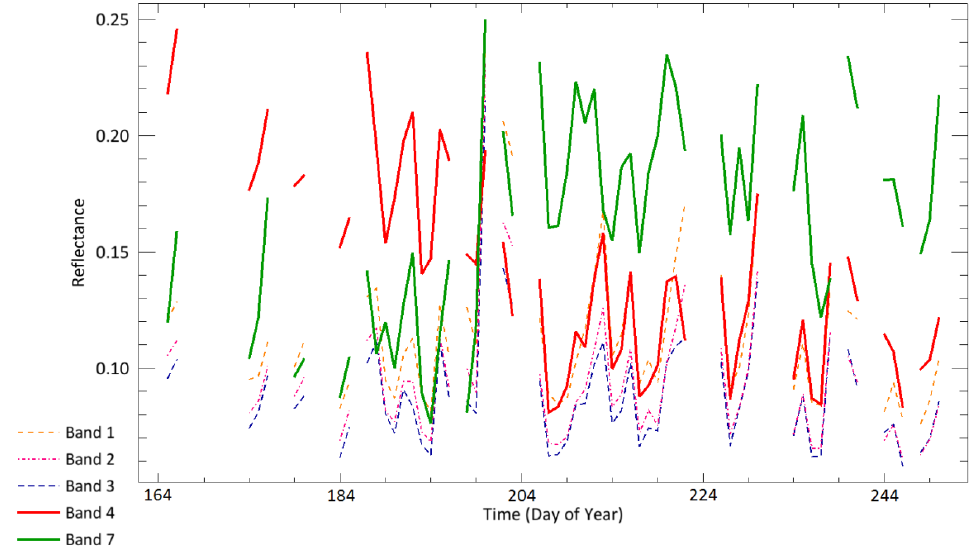
Figure 3. The spectral properties of burned areas in the time series data (after removing the cloud).